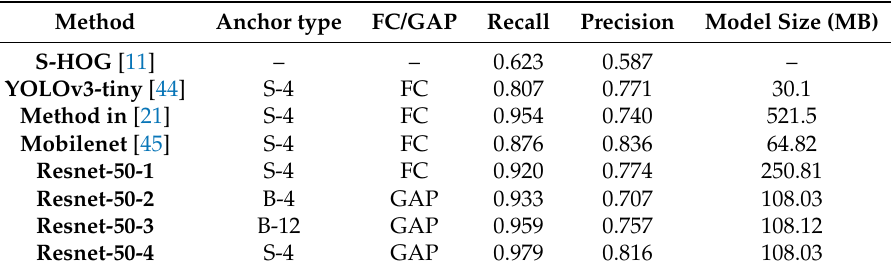
Table 2. Comparisons of different